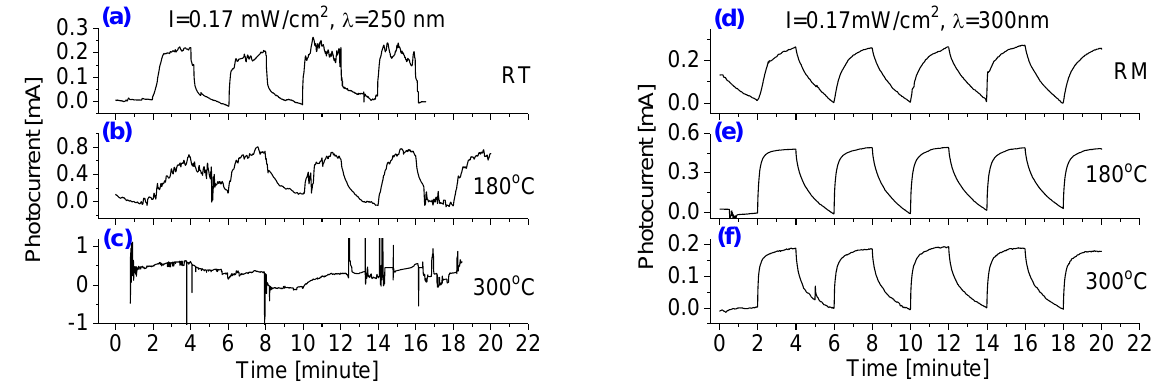
Figure 7. Photocurrents under UV light of 250 nm and 300 nm at an intensity of 0.17 mW/cm 2 with a period of 4 min at 50% duty cycle when operated at ( a , d ) room temperature (RT), ( b , e ) 180 °C, and ( c , f ) 300 °C. The bias voltage is 3.5 V.